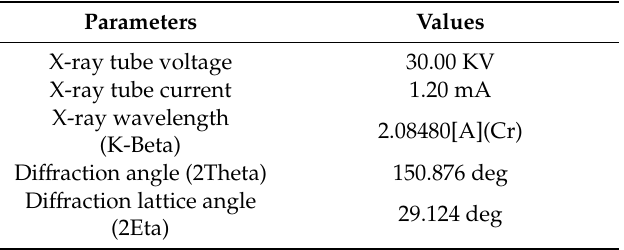
Figure 7. An apparatus of electrolytic corrosion. Table 3. X-ray residual stress measurement parameters.